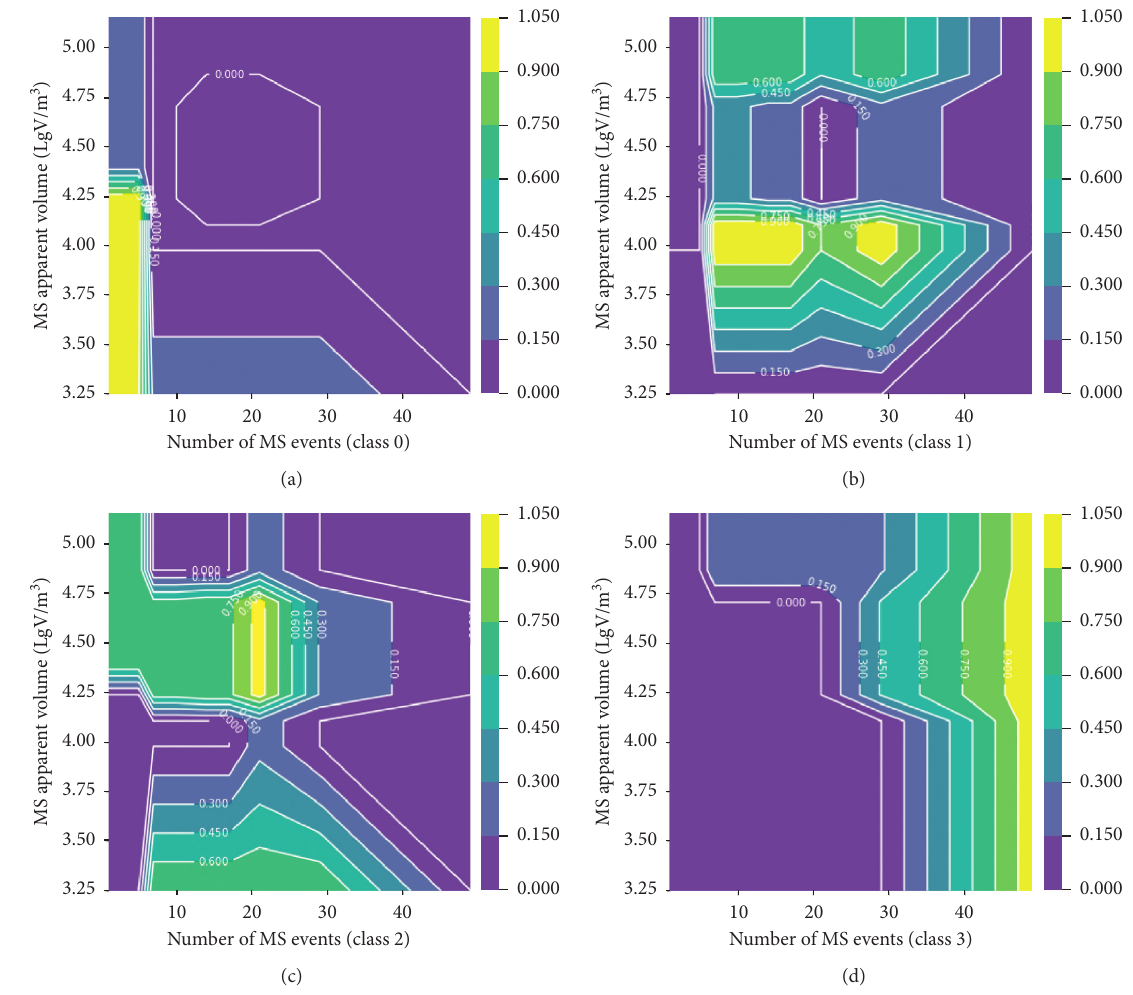
Figure 11: Interactive impact of the energy and apparent volume of MS on